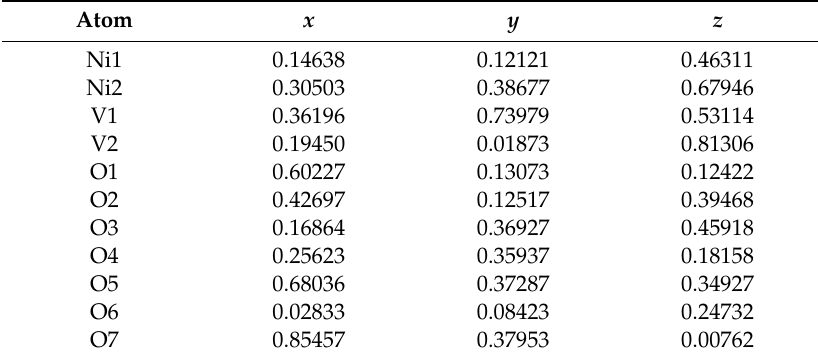
Table A1. Atomic positions of Ni 2 V 2 O 7 obtained from single-crystal XRD analysis.